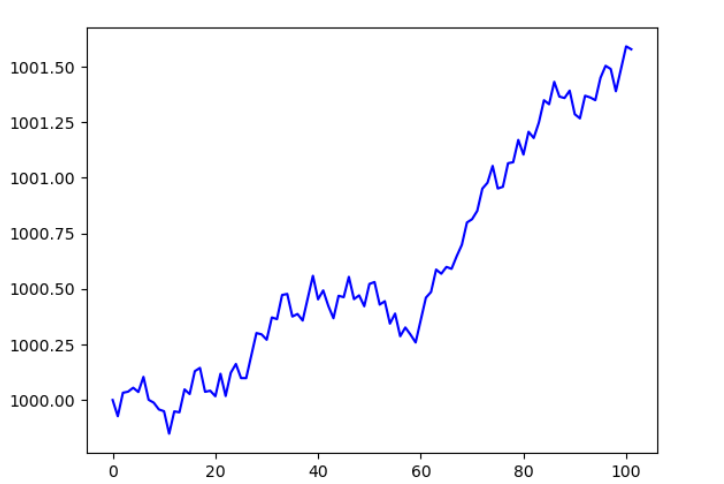
Figure A9. GOLD Margin , 10 m.